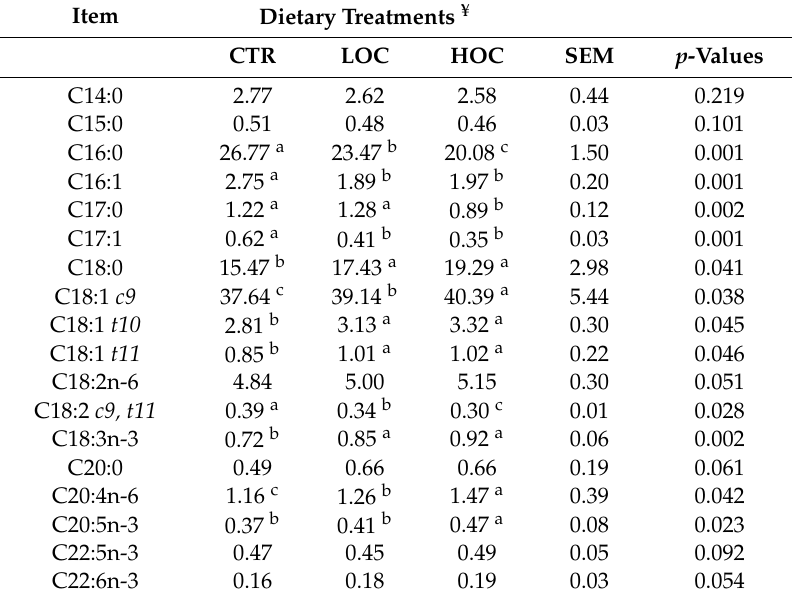
Table 6. E ff ect of dietary olive cake supplementation on fatty acid profile (g / 100 g) § of total lipids in the Longissimus lumborum muscle of Limousin young bull.